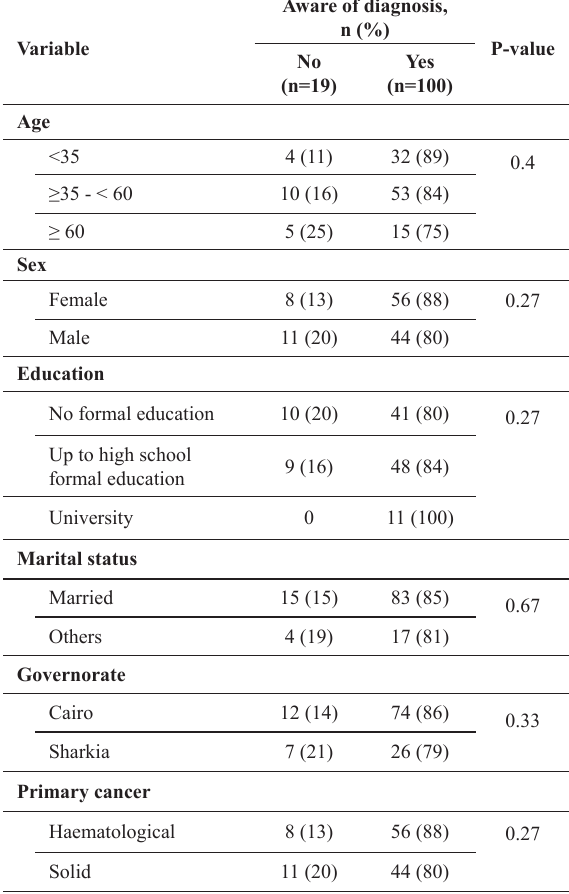
Aware of diagnosis, n (%)